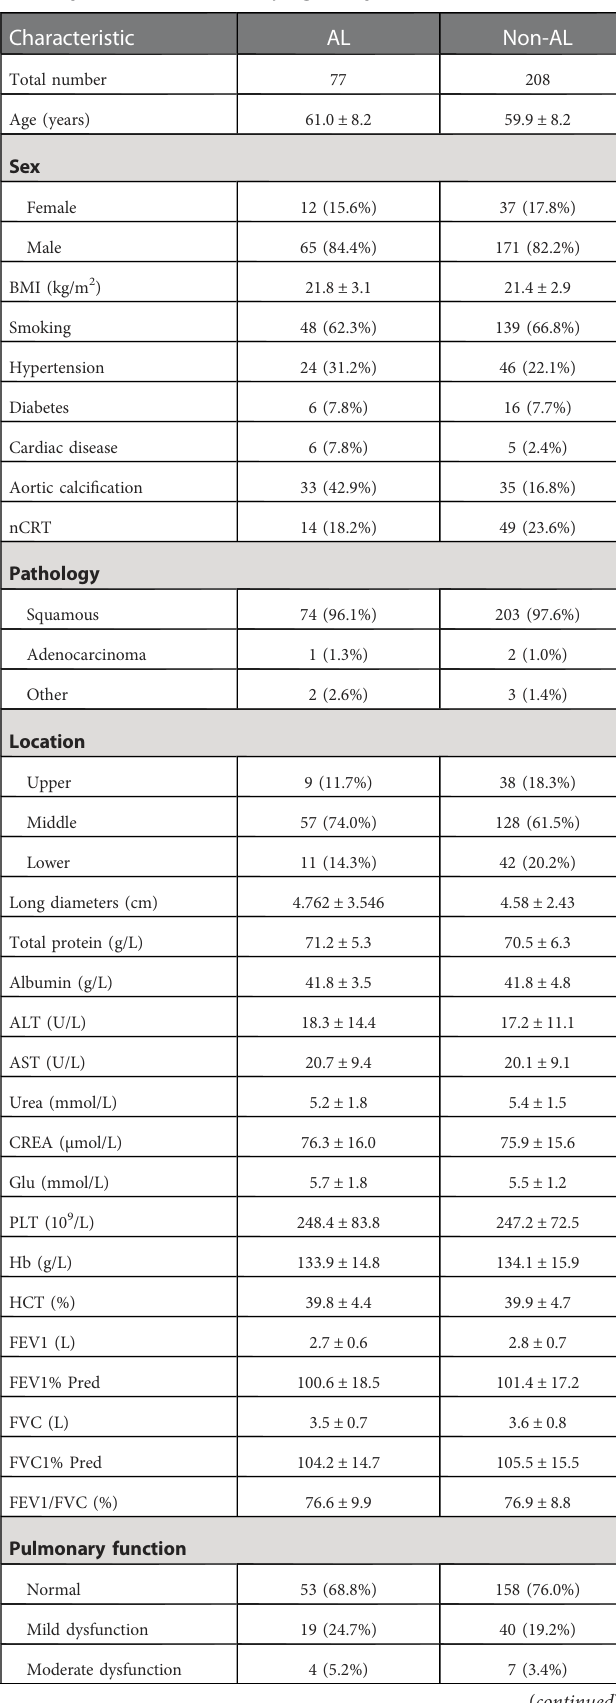
TABLE 1 Demographics and clinical characteristics Among 285 patients with minimally invasive McKeown